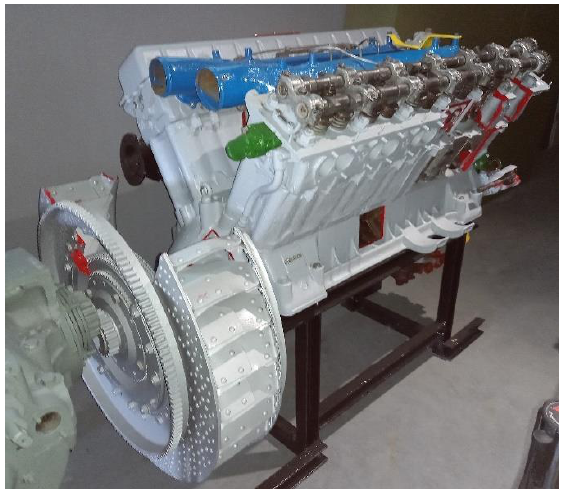
Fig. 12. The W-2 engine (Armored Weaponry Museum, Poznan, photo by the author)